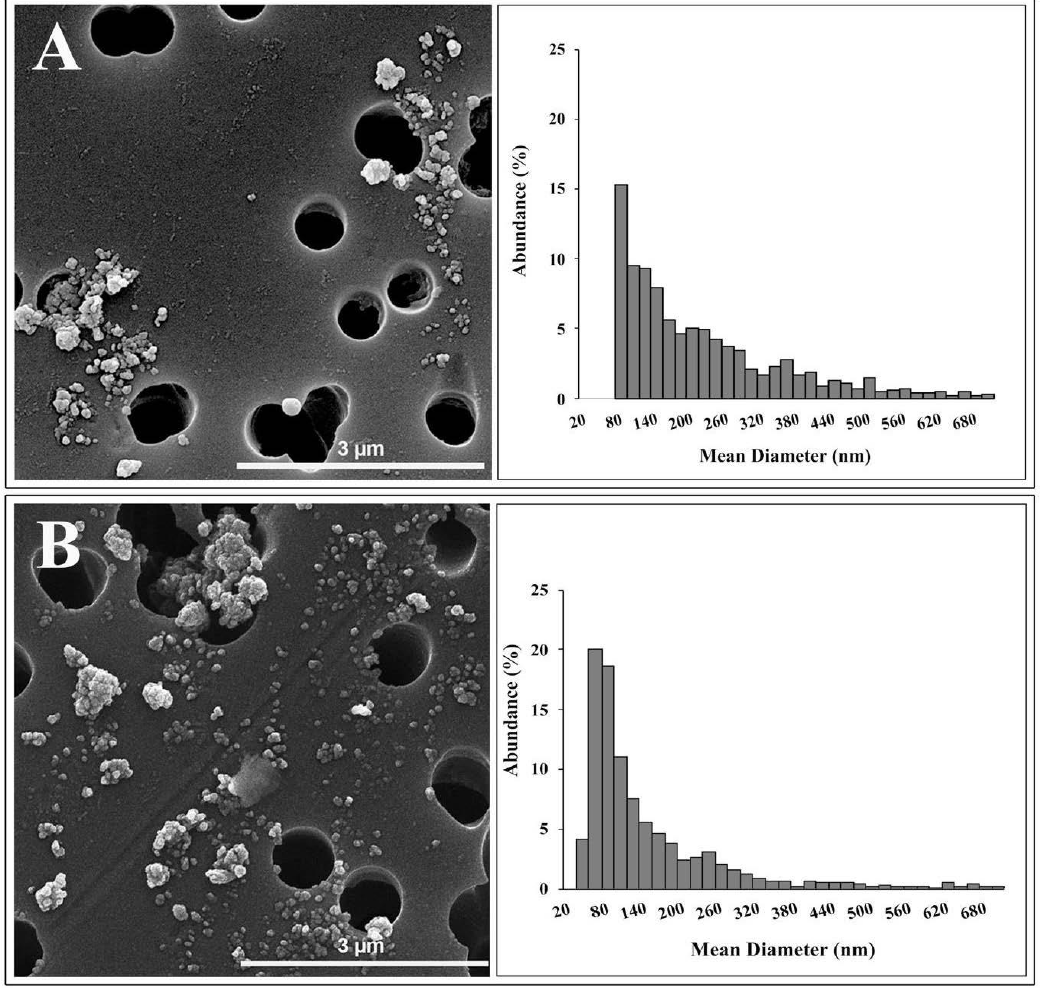
Figure 1. SEM agglomerates and mean diameter distribution of TiO 2 NPs in Milli-Q water ( A ) and DMEM ( B ) determined by SEM analysis. The range of mean diameter between 0 and 700 nm is displayed.